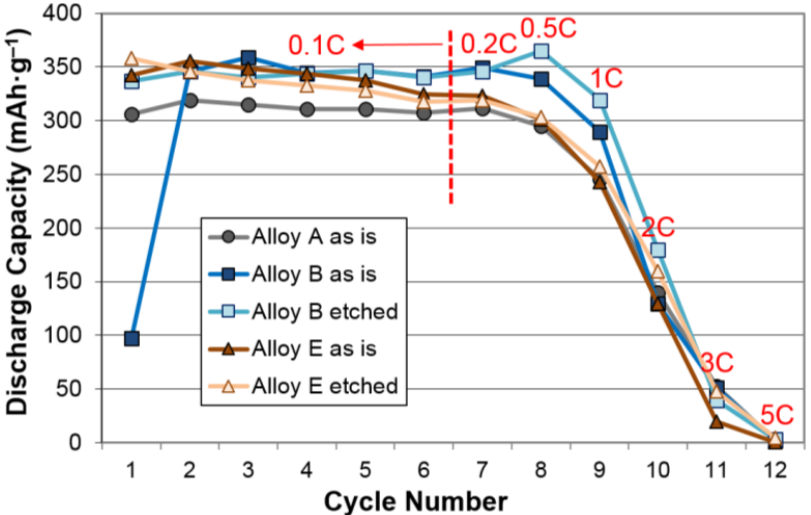
Figure 3. Examples of half-cell discharge capacities measured with 0.1 C (cycle 1–6), 0.2 C (cycle 7), 0.5 C (cycle 8), 1 C (cycle 9), 2 C (cycle 10), 3 C (cycle 11), and 5 C (cycle 12) rates from A (as-in only),